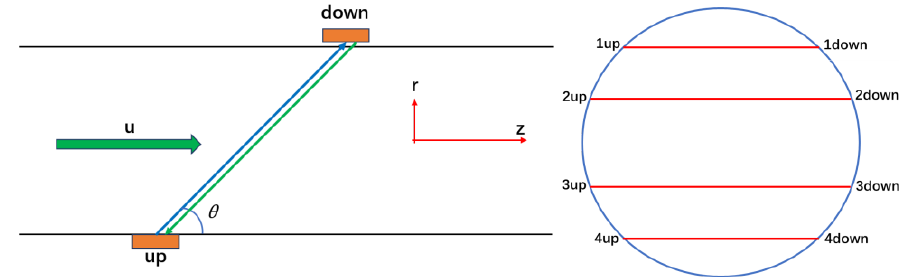
Figure 1. Schematic diagram of time-difference measurement.